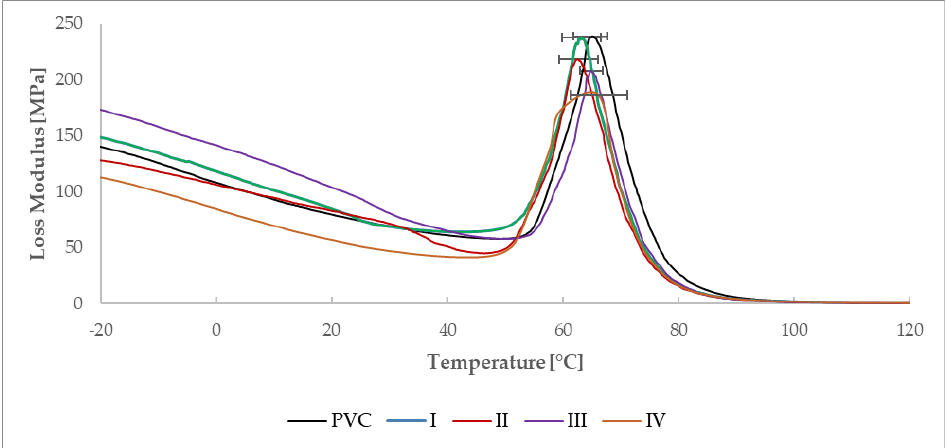
Figure 17. Determined curves of the Loss modulus of the sample PVC, I, II, III, IV.